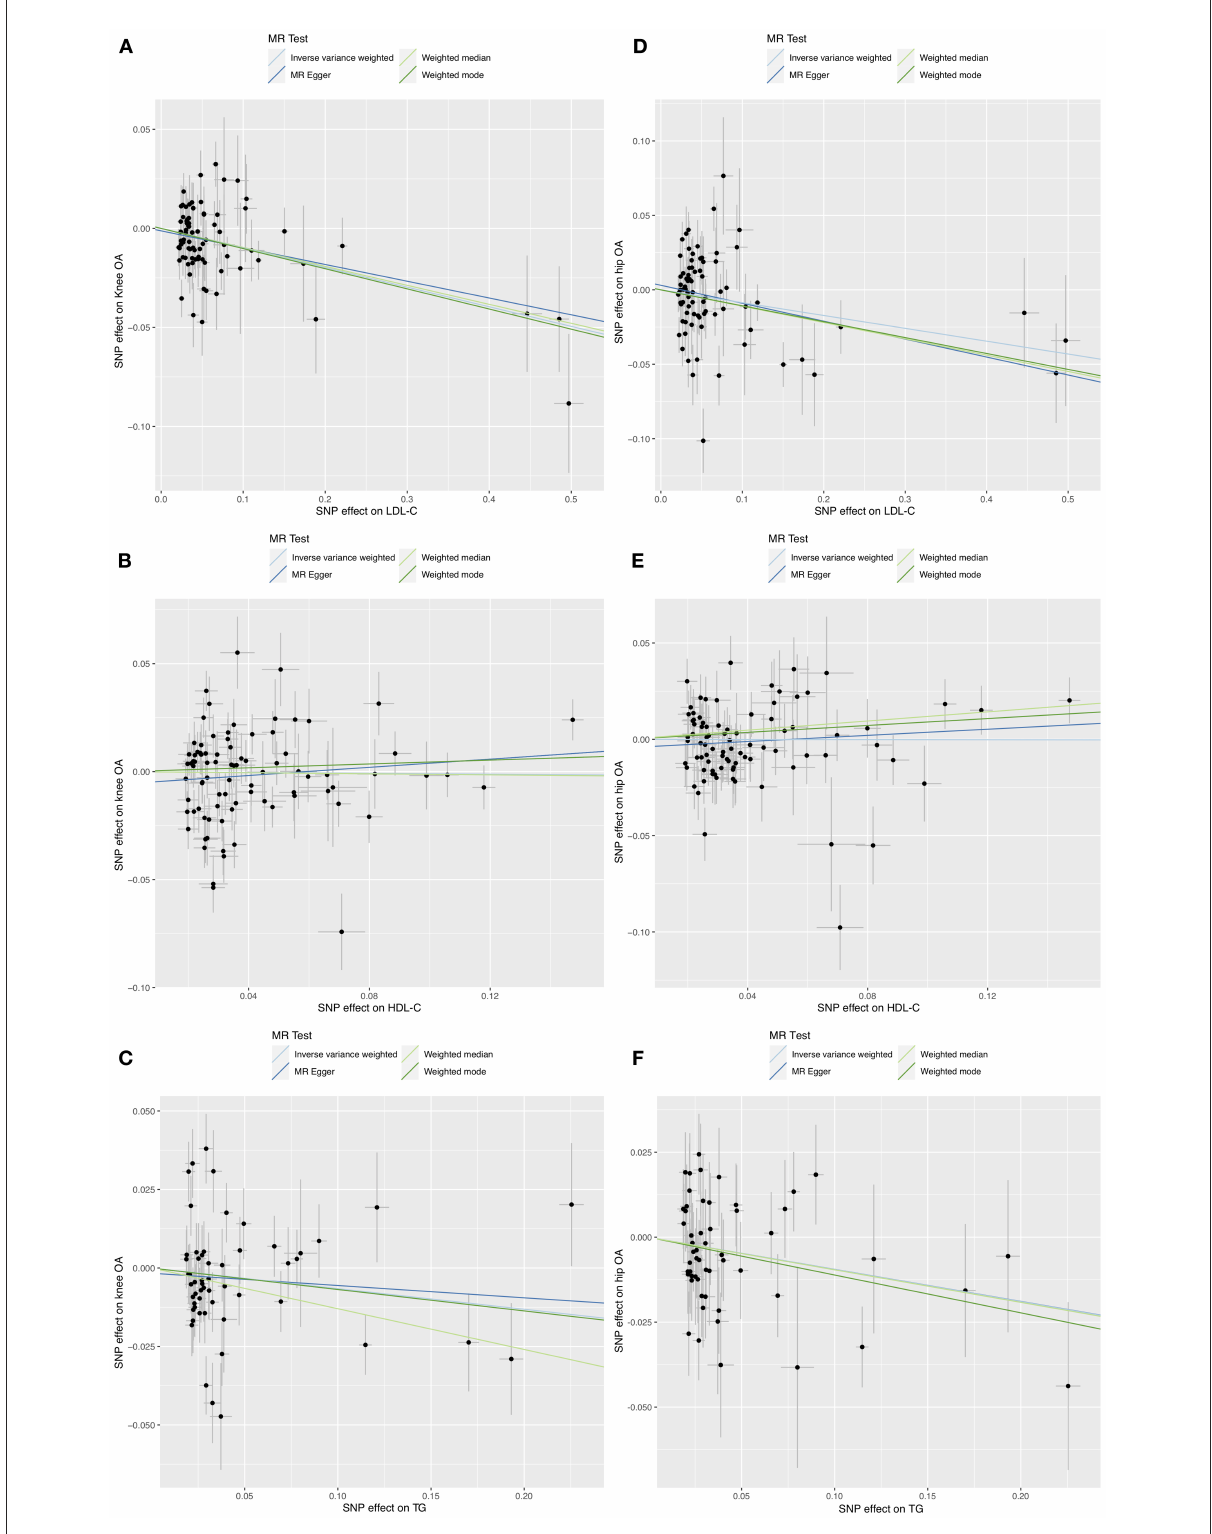
FIGURE1 Scatter plots of MR analyses for the causal effect of LDL-C, HDL-C, and TG on knee (A–C) and hip (D–F) OA